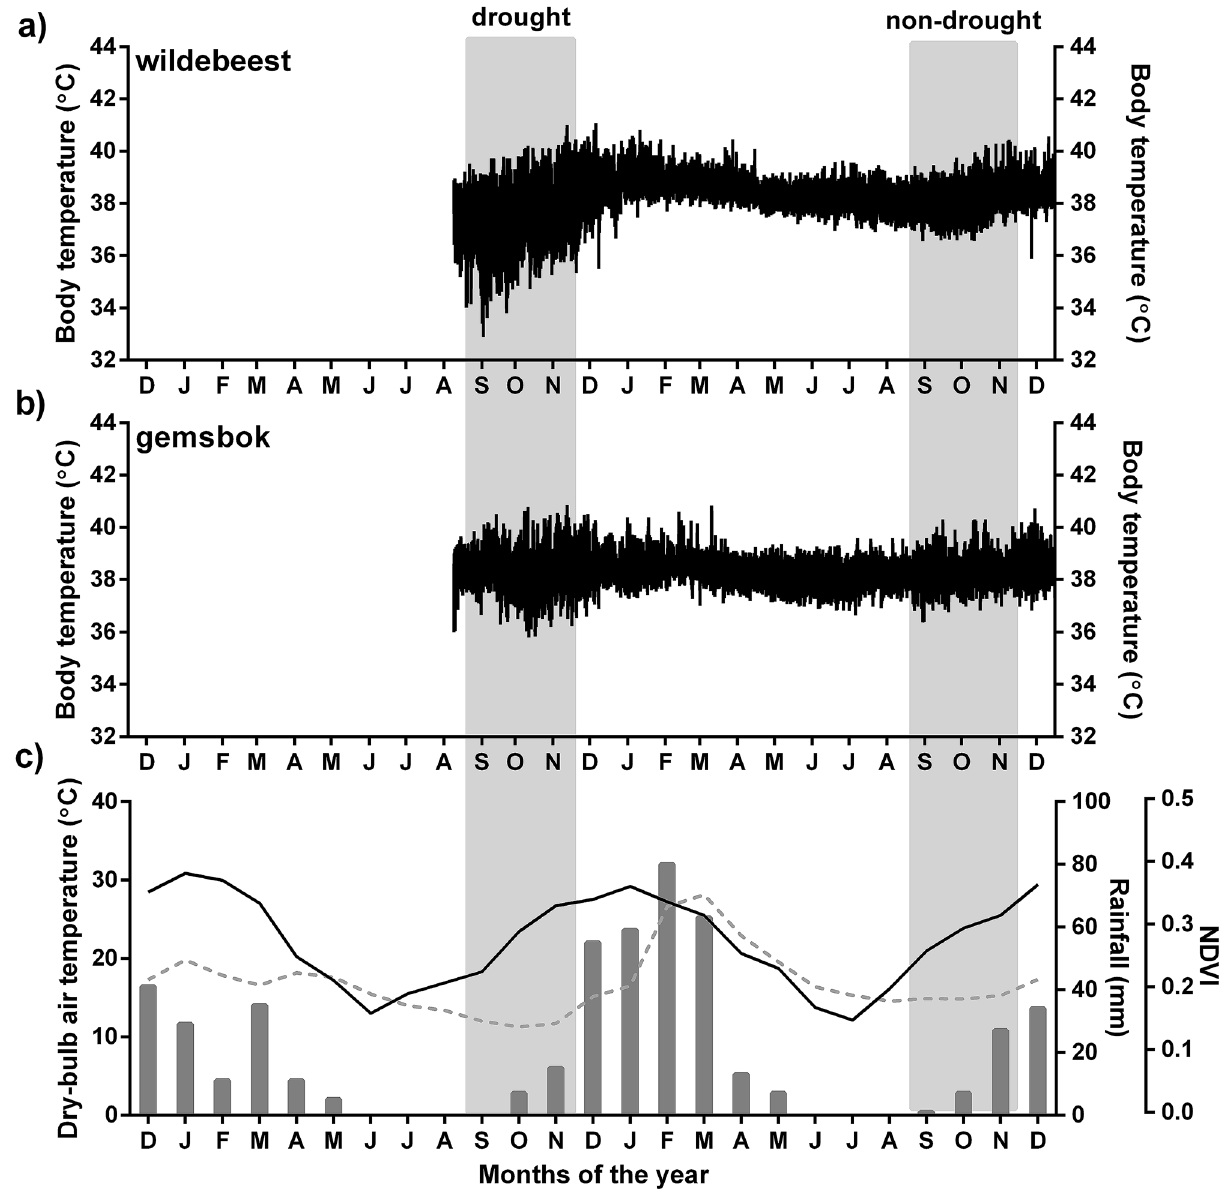
Figure 1. Ten-min recordings of body temperature from a representative female wildebeest ( a ) and female gemsbok ( b ) over the study period (September 2013 to November 2014); and the monthly dry-bulb air temperature (solid black line), rainfall (grey bars) and monthly composited vegetation greenness (NDVI; dashed grey line) over two years ( c ) highlighting drought conditions in the first year. The light grey boxes represent the two hot-dry seasons compared in the current